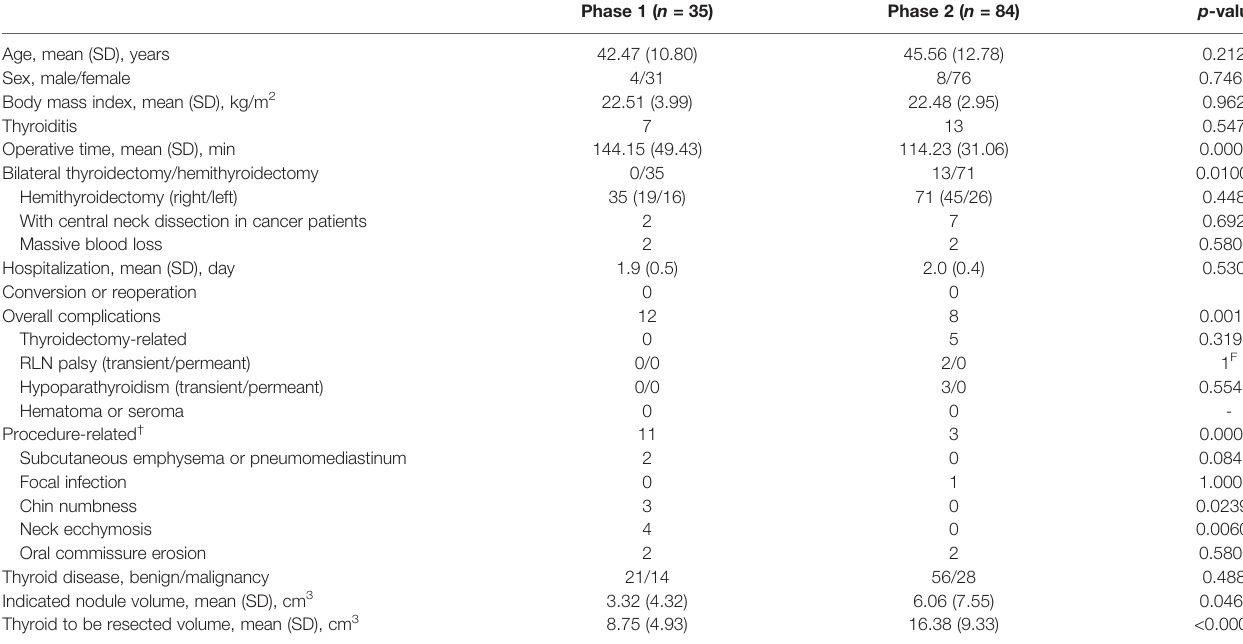
TABLE 2 | Comparisons of demographic data and surgical outcomes between